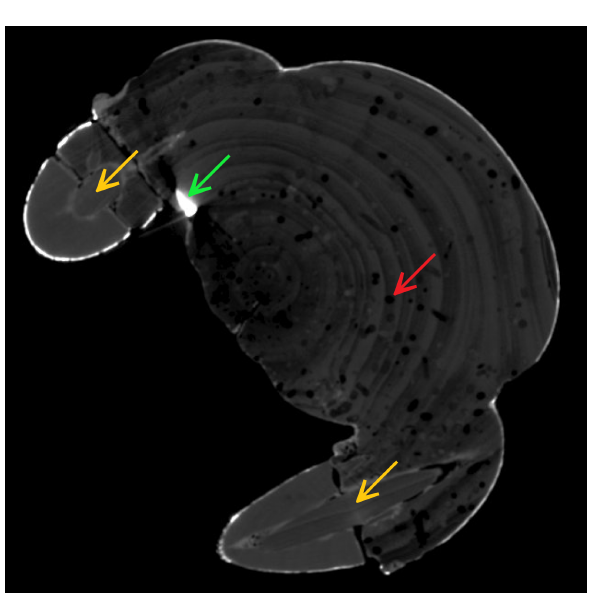
Figure 1: Sculpture of Madonna with child Jesus before the restoration (HMFA, 2009)